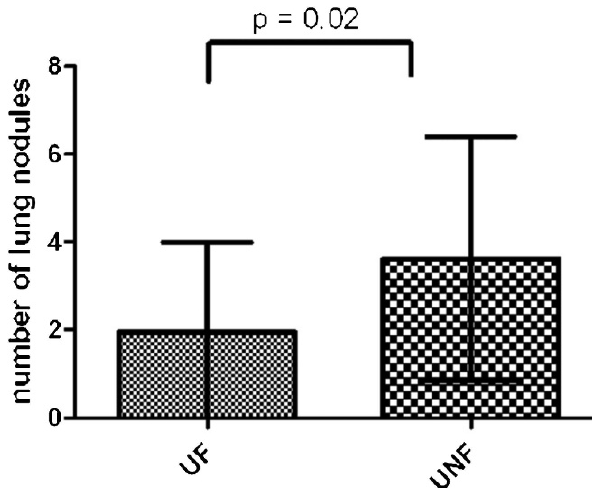
Figure 2 - Graph showing number of nodules counted in urethane-treated animals which was significantly larger in the non-filtered chamber (UNF) in comparison with the filtered chamber (UF)